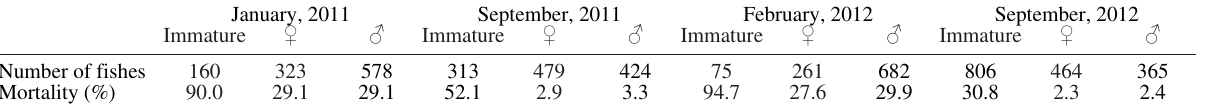
Table 8. – Sex data of red mullet caught from test and open codend